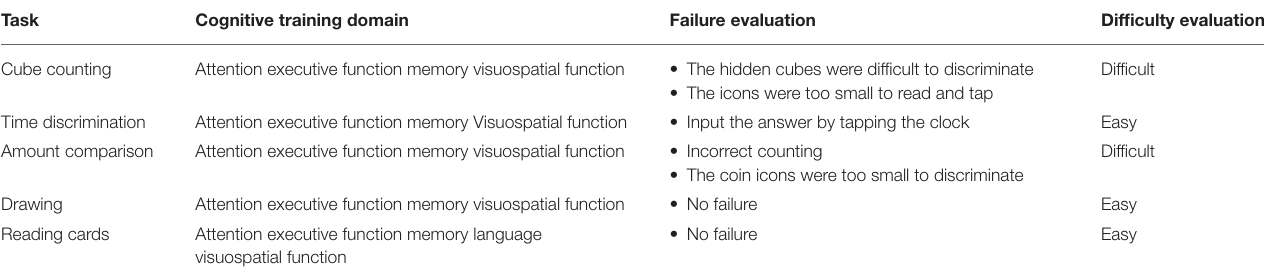
TABLE 5 | Failure and difficulty evaluation of the current cognitive training games.